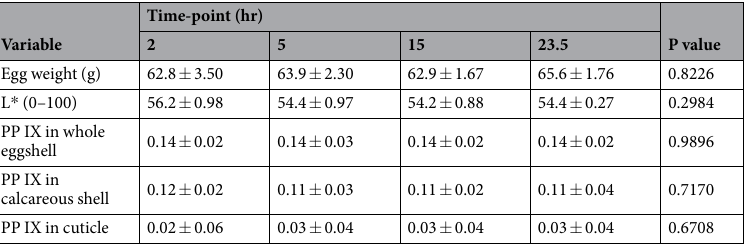
Table 3. Mean values ( ± S.E.) of egg quality variables measured before dividing hens into different groups. Protoporphyrin IX (PP IX) was measured in nMoles per gram of shell with and without cuticle and in cuticle alone. The eggs were collected before dividing the experimental hens into various groups. On the basis of eggshell variables, hens were divided into groups in such a way that the variables were not significantly different among